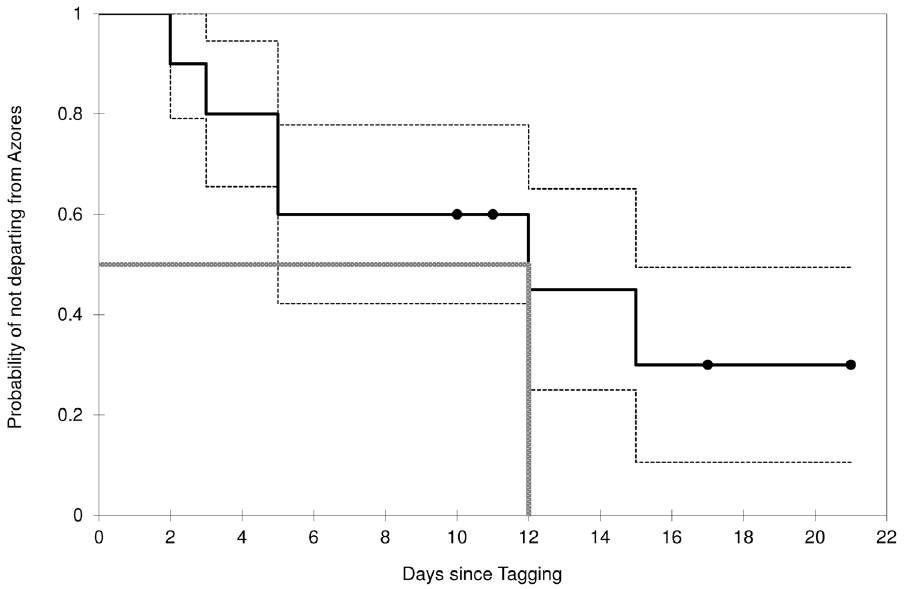
Figure 2. Probability of fin whales not departing from the Azores over time. Kaplan-Meier estimate (solid line) of the probability of fin whales not departing (1-probability of departure) from the Azores at various days since tagging (DST). The black dots represent the censored observations (whales whose tags stopped transmitting prior to departure). The dotted lines represent the 25% and 75% estimated probabilities of fin whales not departing from the Azores in relation to DST. The median DST to departure (the DST at which half of the whales have departed) is indicated by the gray dashed line.